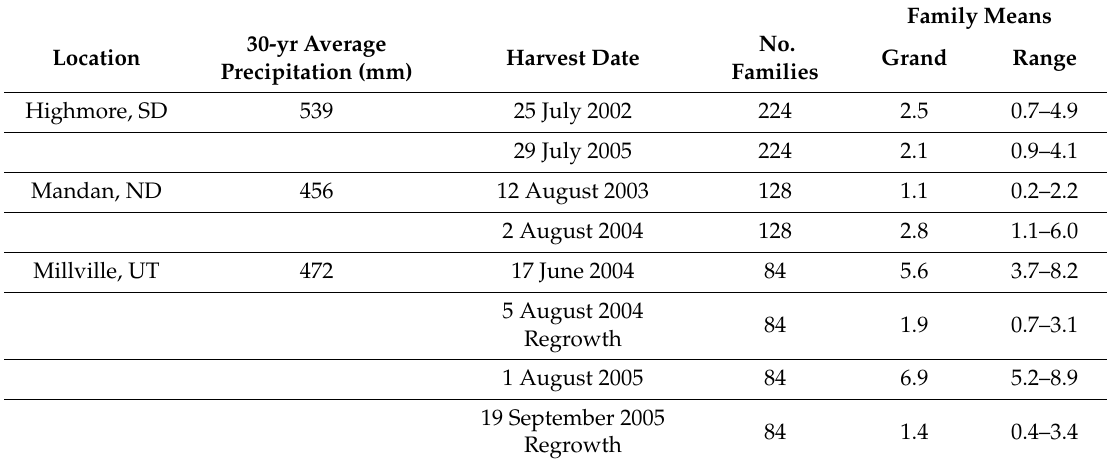
Table 1. Dry matter forage production (Mg ha − 1 ) for half-sib families of the Grand River National Grassland population of yellow-flowered alfalfa in North Dakota, South Dakota, and